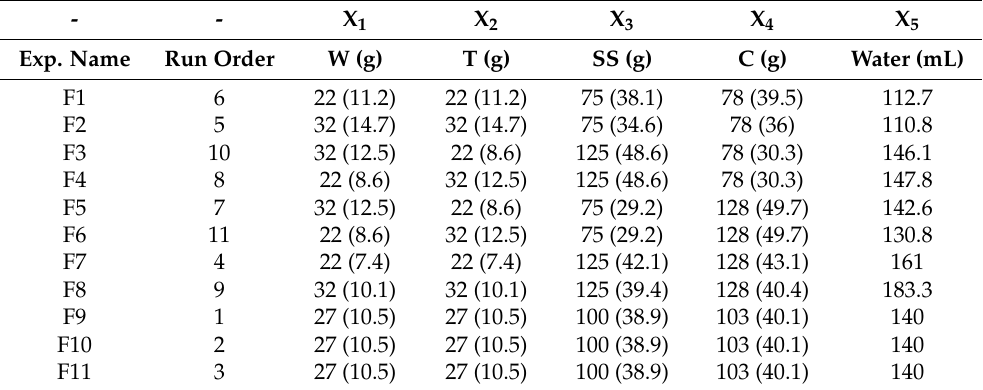
Table 1. Experimental design for flatbread development. The percentages of flour expressed in 100 g of composite flour are in